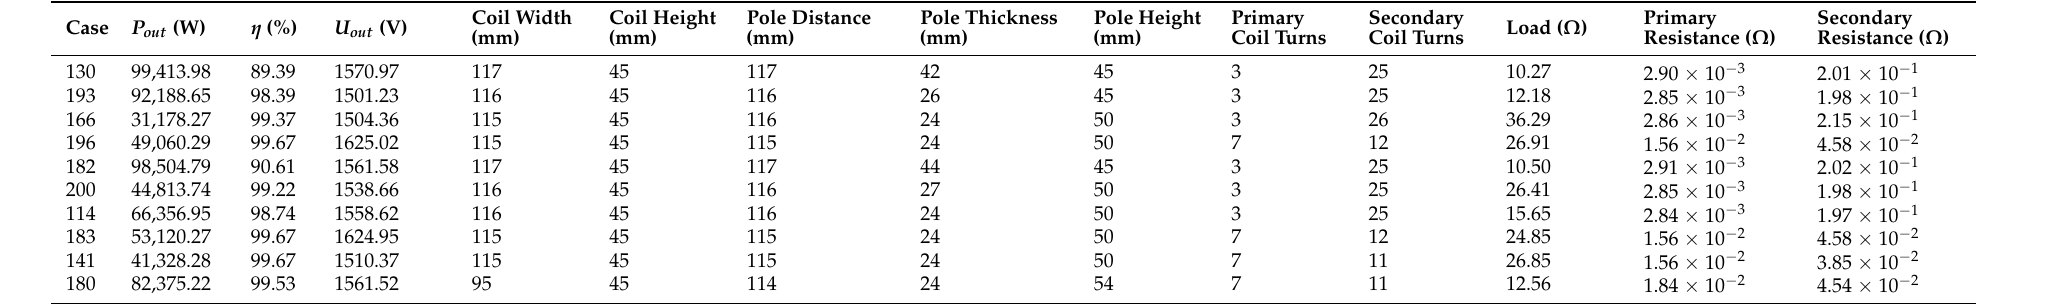
Table 4. The parameters of the generated Pareto